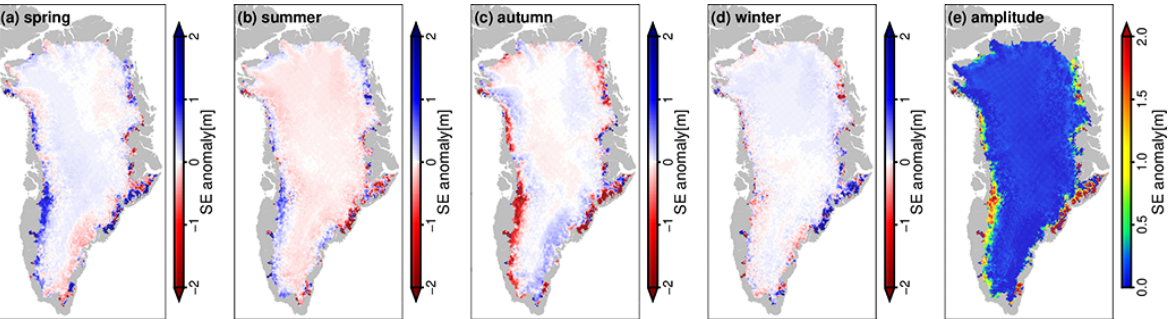
Figure 4. Climatological maps of the SE anomaly averaging season by season: (a) spring (January–February–March), (b) summer (April– May–June), (c) autumn (July–August–September), and (d) winter (October–November–December) and (e) the amplitude of corresponding annual variation over the periods of 1991–2020 from the merged elevation time